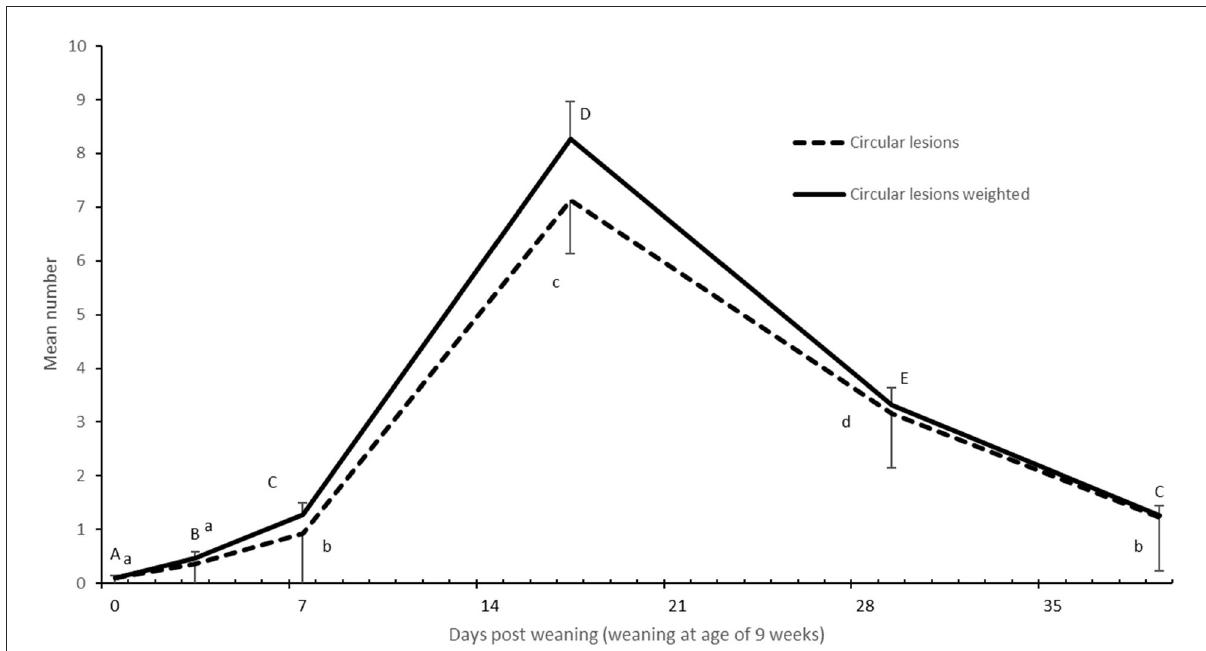
FIGURE3 Development of the number of circular lesions (mean ± SE) per pig on the flanks of 69 pigs after weaning at 9 weeks of age. Means with different capital letters indicate a significant difference between days in the weighted number of circular lesions, and different lower-case letters indicate a significant difference between days in the number of circular lesions ( P < 0.05). The weighted number of circular lesions was calculated by multiplying the number of severe lesions by two and summing it with the number of small lesions to reflect the size and severity of